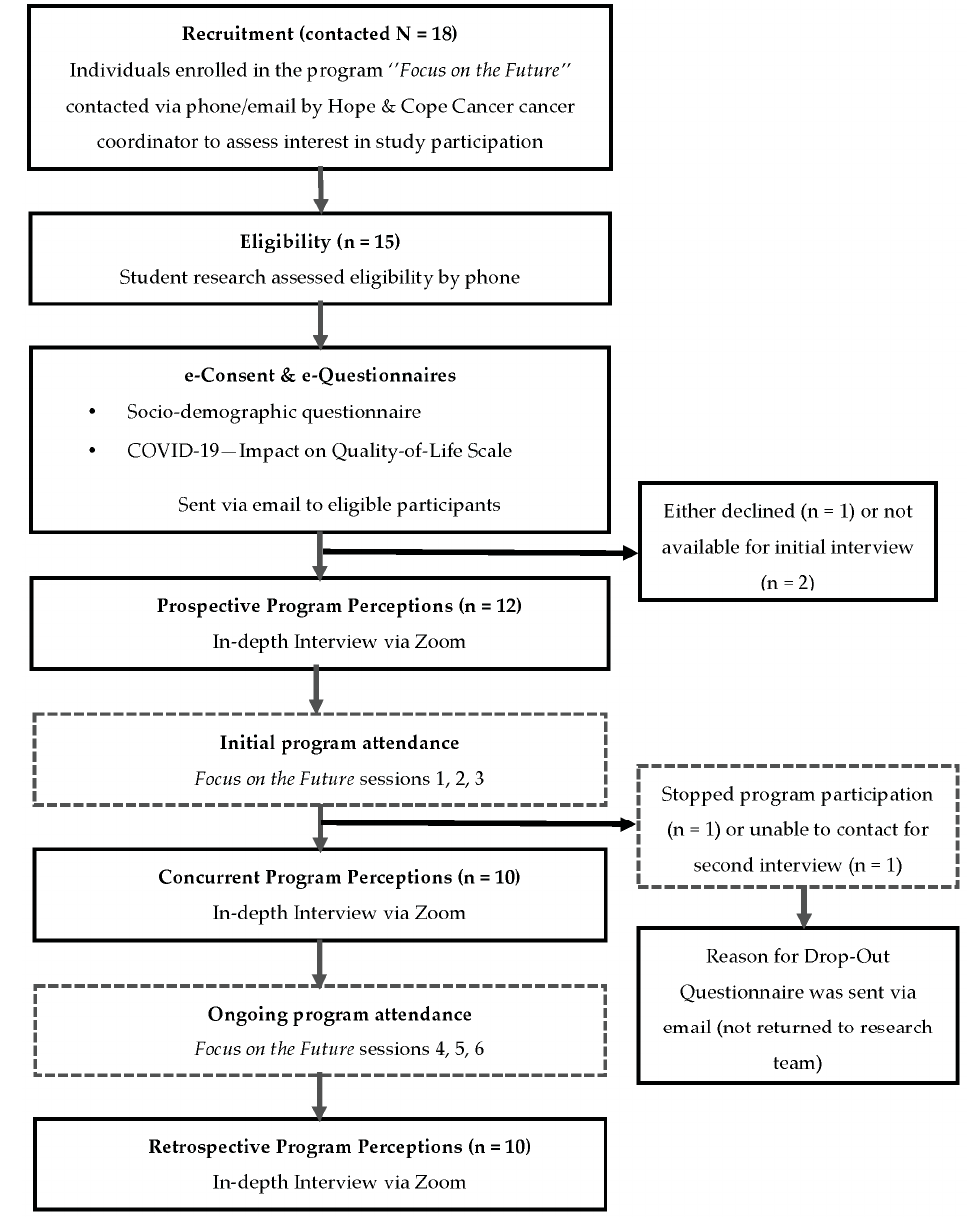
Figure 1. Data collection flowchart.